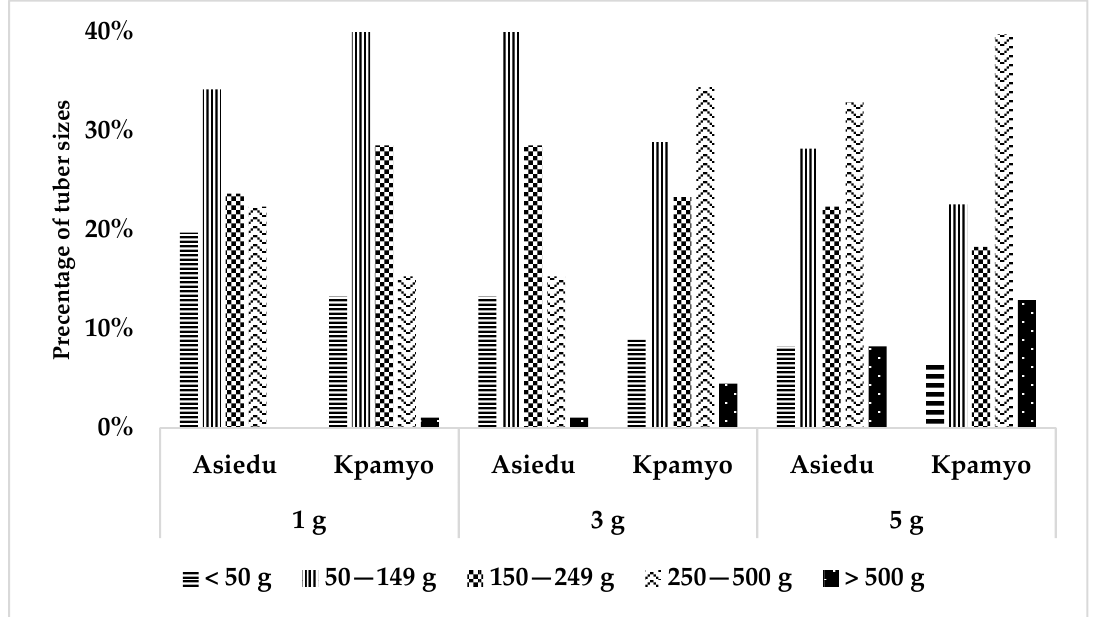
Figure 4. Percentage of various categories of tubers produced by different minituber sizes of yam varieties Kpamyo and Asiedu.